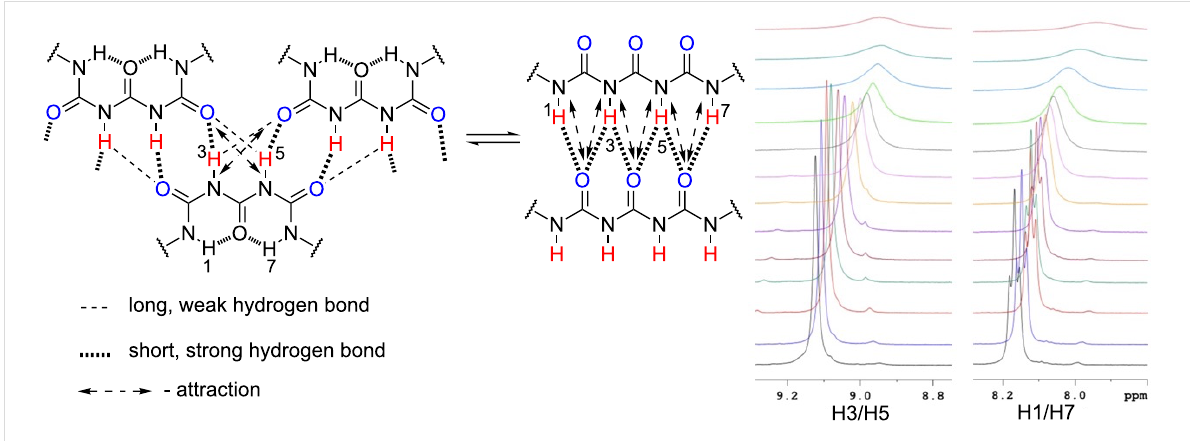
Figure 4: Two possible, extreme multiple hydrogen bonded multimeric structures of 1 and VT 1 H NMR spectra (from +25 to − 40 °C, low tempera- tures at bottom, CDCl 3 ).